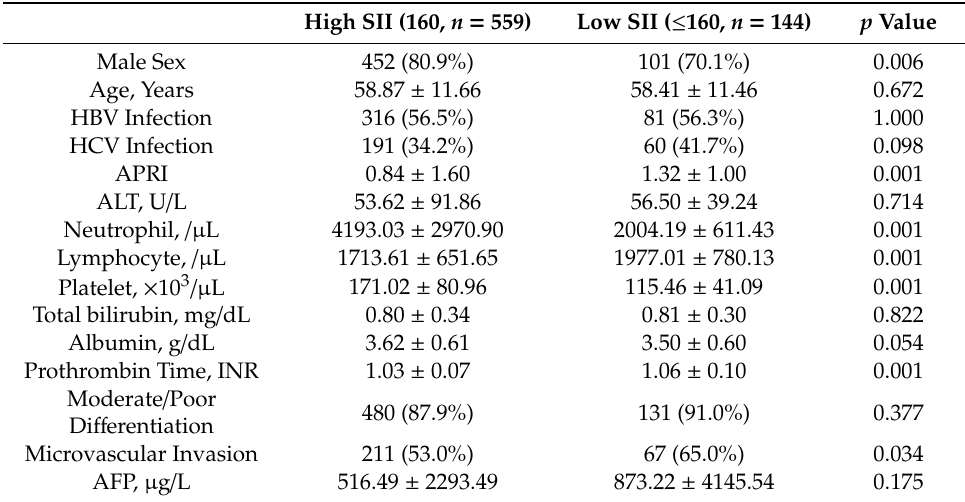
Table 7. Comparison of characteristics between patients with high and low